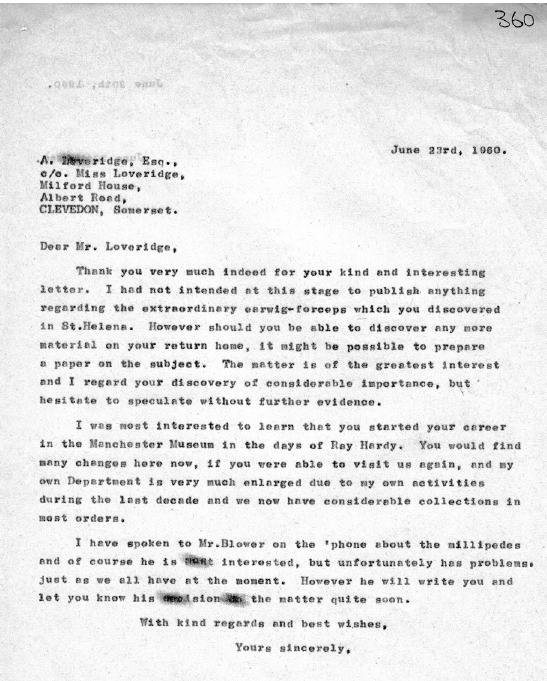
Fig. 14. Letter from Arthur Loveridge to Hincks relating his unsuccessful search for the Giant Earwig (MMUE, Hincks archive, item